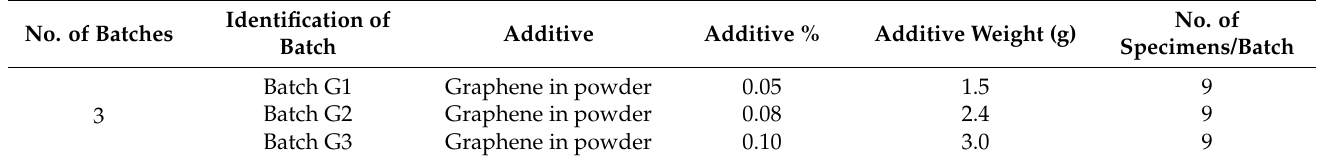
Table 5. Dosages, quantity, and nomenclature of specimens with added